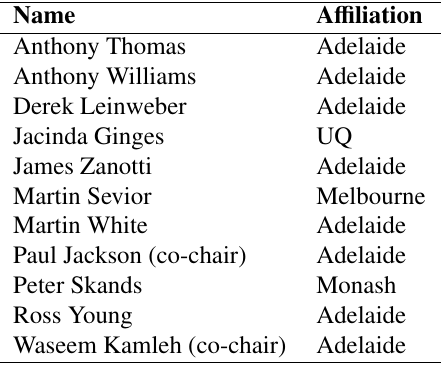
Table 5: CHEP 2019 Local Organising Committee